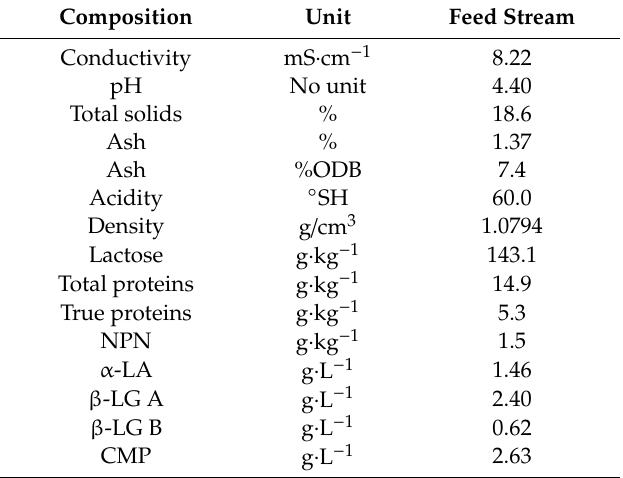
Table 2. Feed (nanofiltrated acid whey) composition and physicochemical